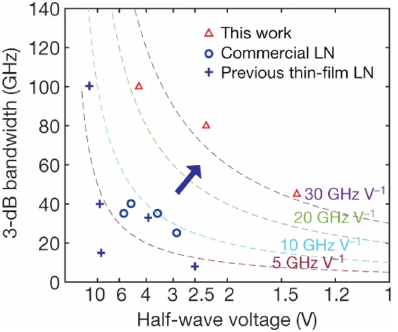
Figure 19: The voltage-bandwidth trade-off of LNOI modulator.